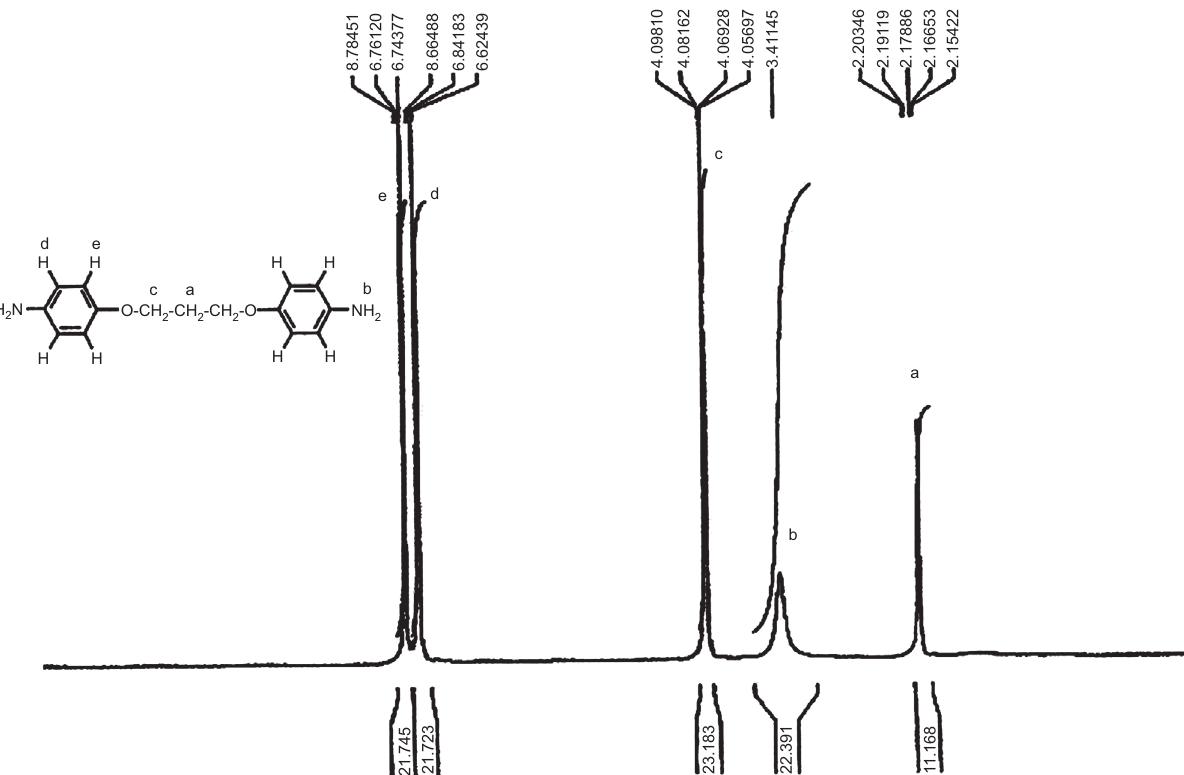
Figure 1 1 H-NMR spectrum of diamine 4 .